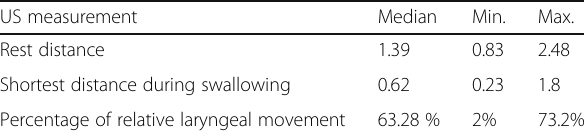
Table 1 The median value measured by the